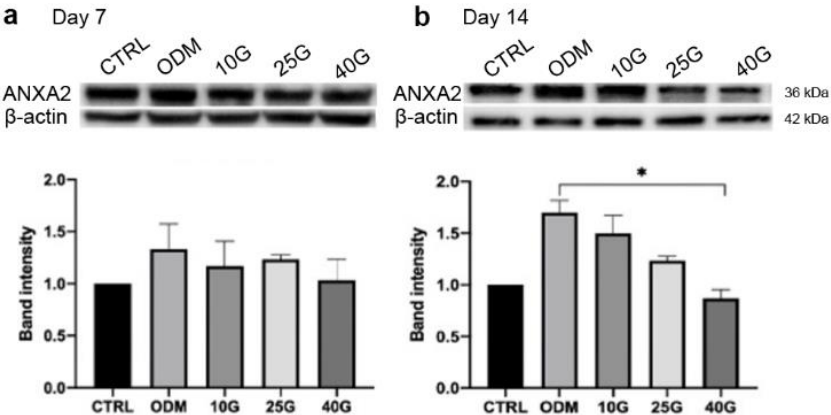
Figure 3. The expression of ANXA2 in MSCs during osteogenic differentiation under high-glucose condition. Western blot analysis demonstrated ANXA2 expression at day 7 ( a ) and day 14 ( b ) in MSCs in growth medium (CTRL), ODM (5.5 mM glucose), ODM with 10 mM (10G), 25 mM (25G), and 40 mM (40G) glucose. The protein band intensity is presented as relative to CTRL. All data are presented as the means ± SEM from three independent experiments. * p value < 0.05 is considered statistically significant.